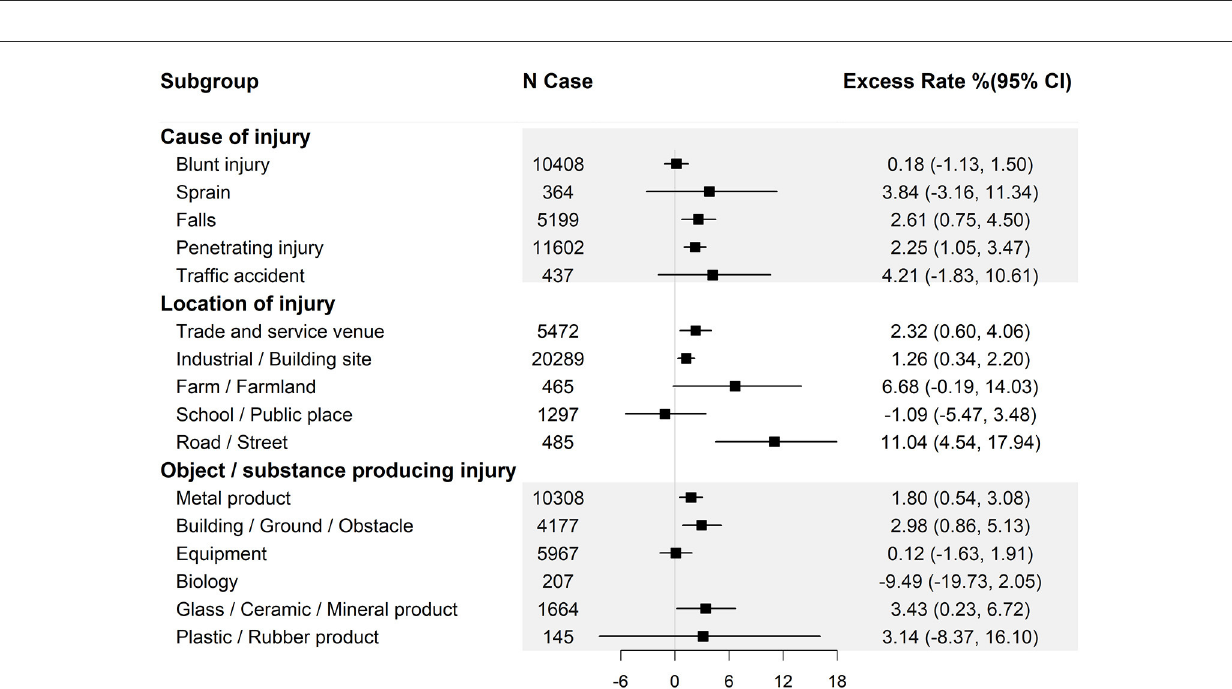
FIGURE2 Excess rate (and 95% confidence intervals) of injuries at work associated with 10mm increase in precipitation by cause of injury, location of injury, and item involved. CI, confidence interval.